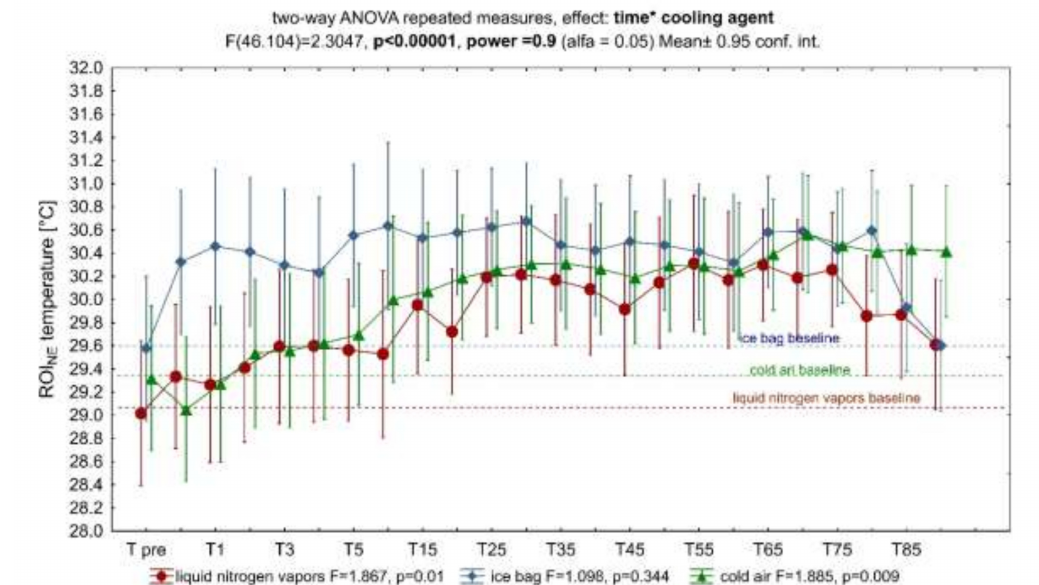
Figure 6. Characterization of the influence of exposure with cooling agents on the ROI NE temperature during 90 min of observation. Legend: analysis of variance for repeated measurements, significance of the influence of time and cooling agent interactions on the ROI NE